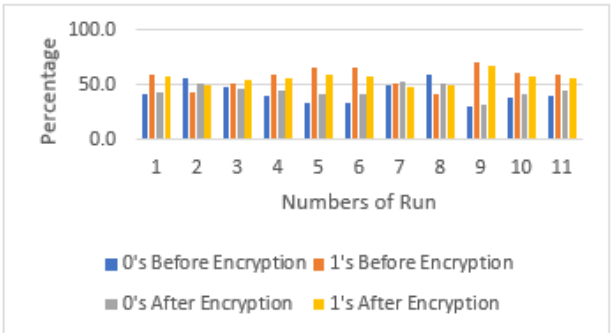
Figure 5. ( a ) Implementation of all 3 algorithms in configuration 1, ( b ) implementation of all 3 algo- rithms in configuration 2.